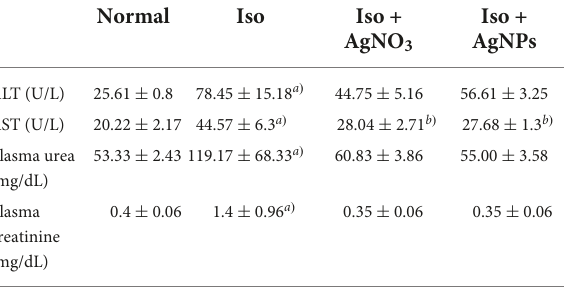
TABLE 2 Liver and kidney functions among the